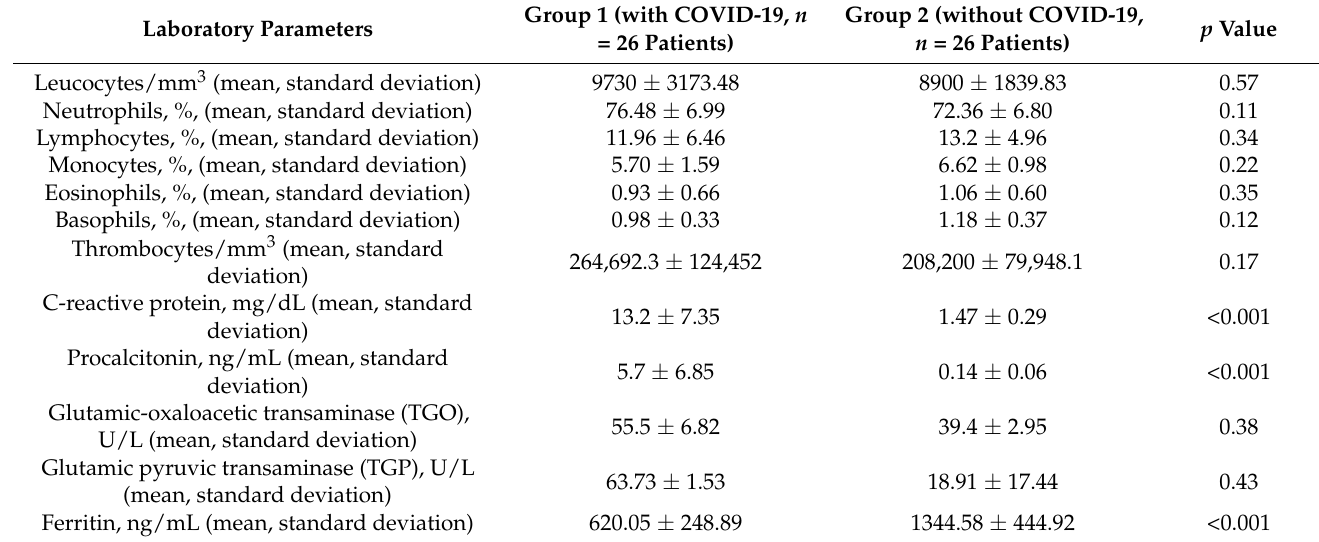
Table legend: TGO—Glutamic-oxaloacetic transaminase, TGP—Glutamic pyruvic transaminase. Our results failed to indicate a statistically significant difference between the two groups regarding the pregnancy outcomes: gestational age at birth ( p = 0.42), birth